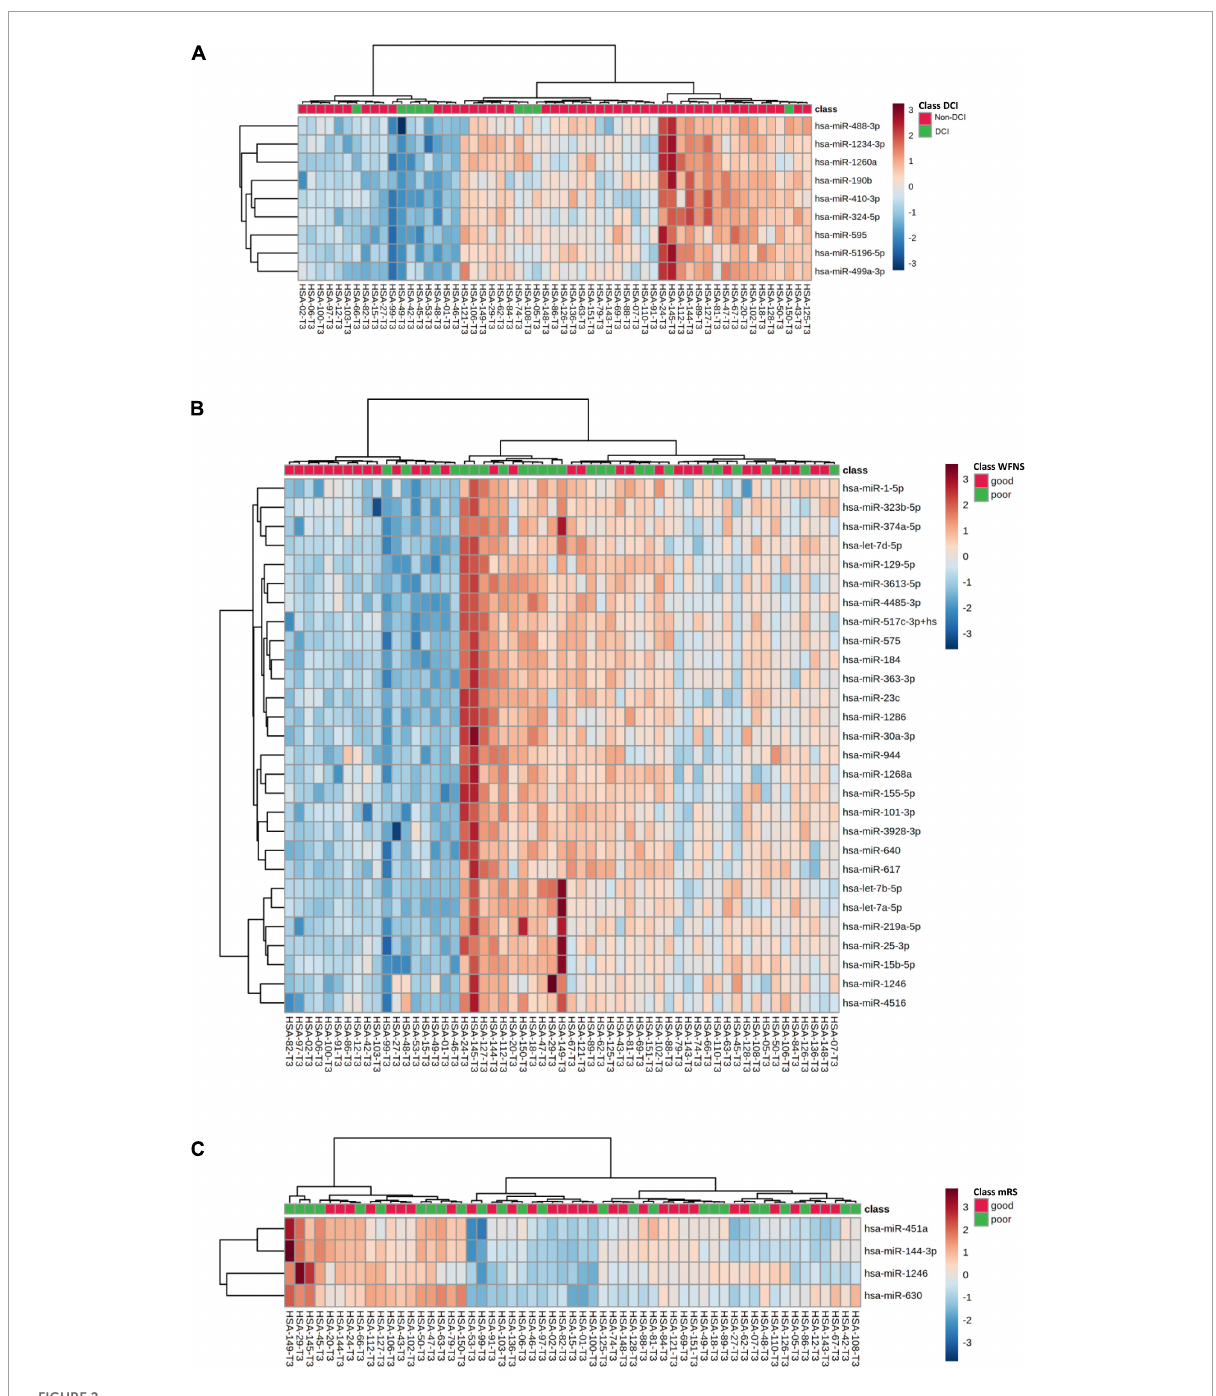
FIGURE2 Unsupervised hierarchical clustering analysis obtained with the expression of selected miRNAs in DCI (A) , WFNS (B) , and modified Rankin Scale at 3 months (C) groups. Genes and samples were clustered according to their expression and similarity. On the top, the type of samples is color-coded: green for SAH samples and red for control samples. The color scheme represents the Z-score distribution from –3 (blue, low expression) to 3 (red, high expression).